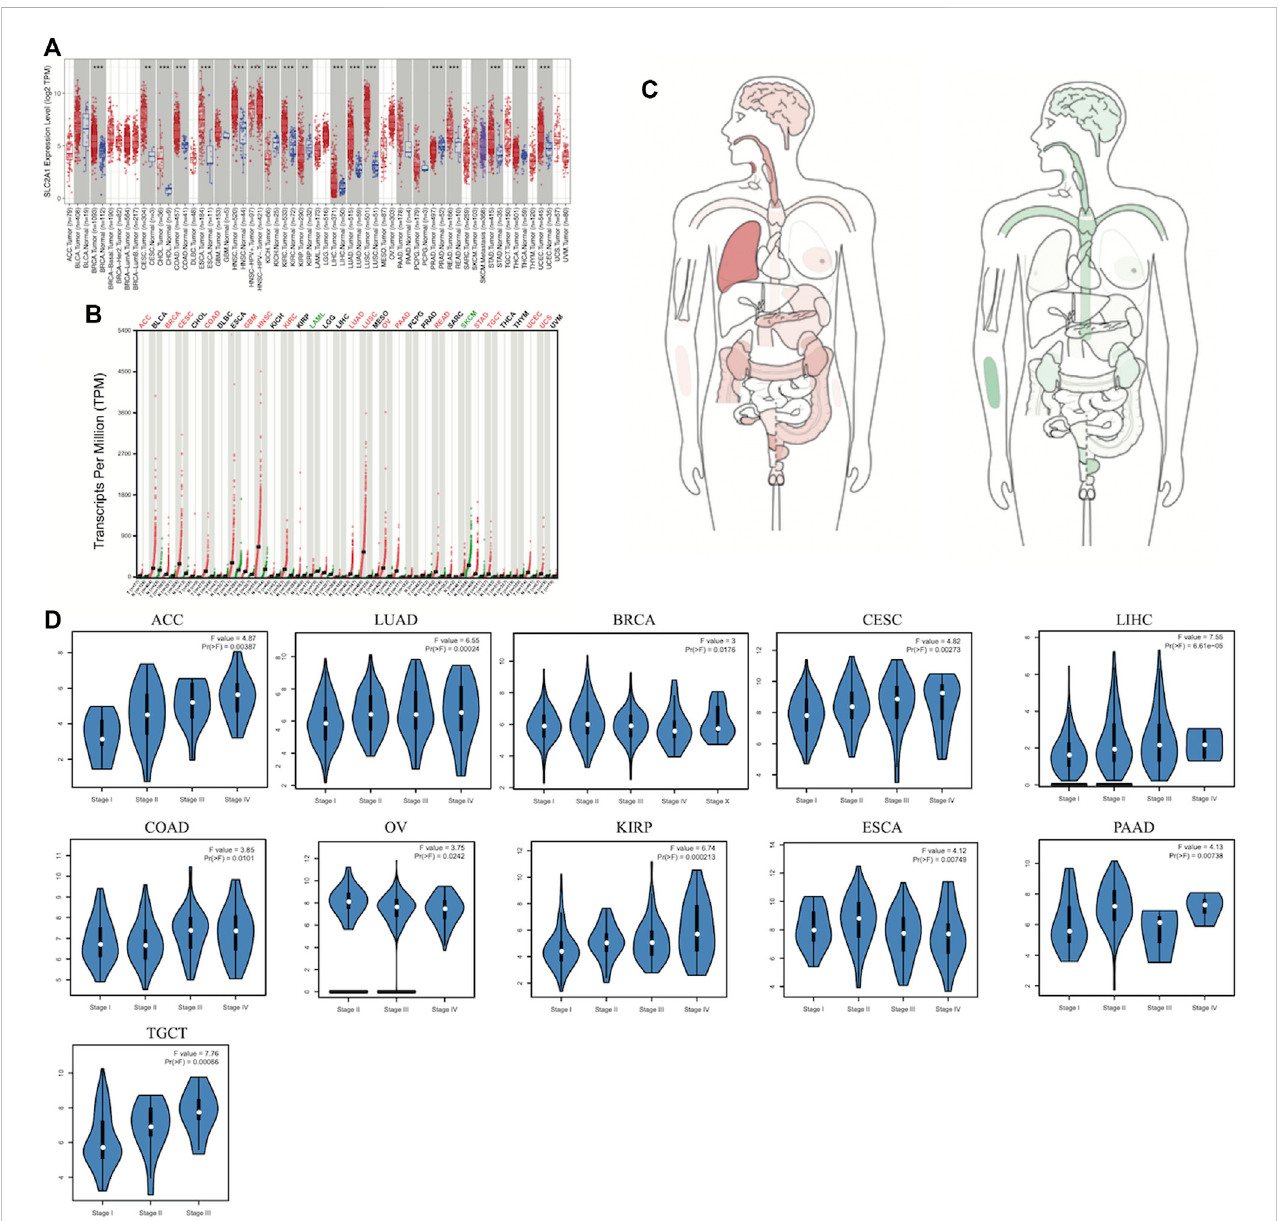
FIGURE 1 Aberrant transcriptome pro fi les and DNA methylation level of SLC2A1 in pan-cancer (A) mRNA level of PDHA1 performed by the TIMER2 database (B) GEPIA2.0 depictedtheSLC2A1 expression inmatchedtumorsgroupand normalgroup (C) ThemedianexpressionofSLC2A1 oftumorandnormal